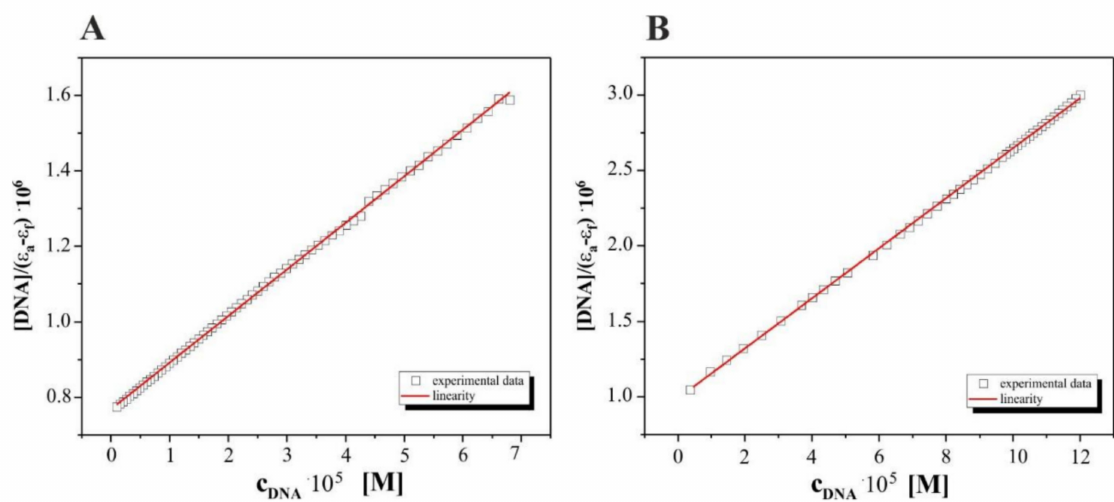
Figure 7. Individual plots of [DNA]/( ε a − ε f ) vs. [DNA] for the absorption titration of DNA ( E.coli ) with complexes: ( A ). [CoCl 2 (dap) 2 ]Cl ( 1 ) and ( B ). [CoCl 2 (en) 2 ]Cl ( 2 ) studied in Tris–HCl buffer; association constant K b : 0.75 · 10 3 M − 1 (R = 0.99950, n = 70 experimental points) for ( 1 ); . K b : 8.0 · 10 5 M − 1 (R = 0.99987, n = 46 experimental points) for ( 2